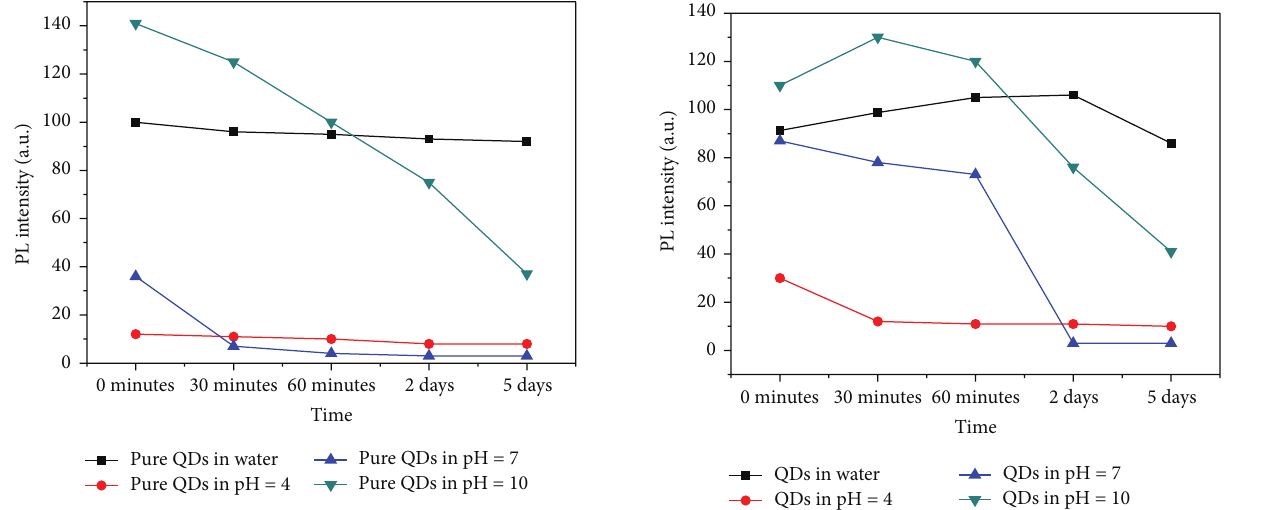
Figure 4: PL spectra of silica coating of QDs in the different buffers tested for different